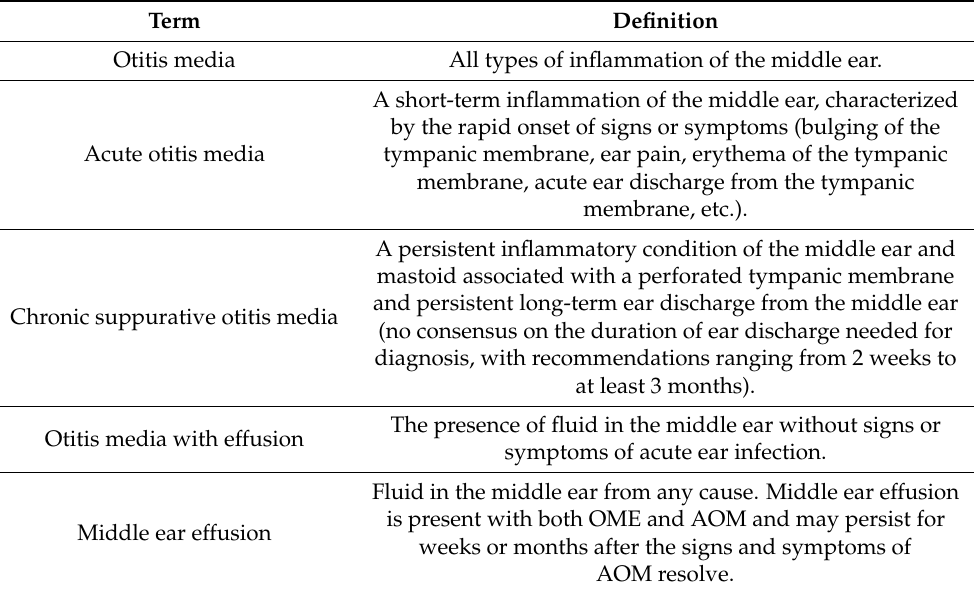
Table 1. Definition of otitis